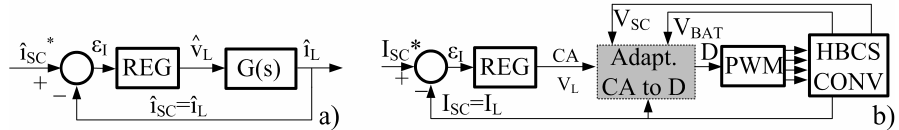
Figure 16. Inner control loop approach ( a ) for designing and tuning the regulator and ( b ) for implementing the control scheme.